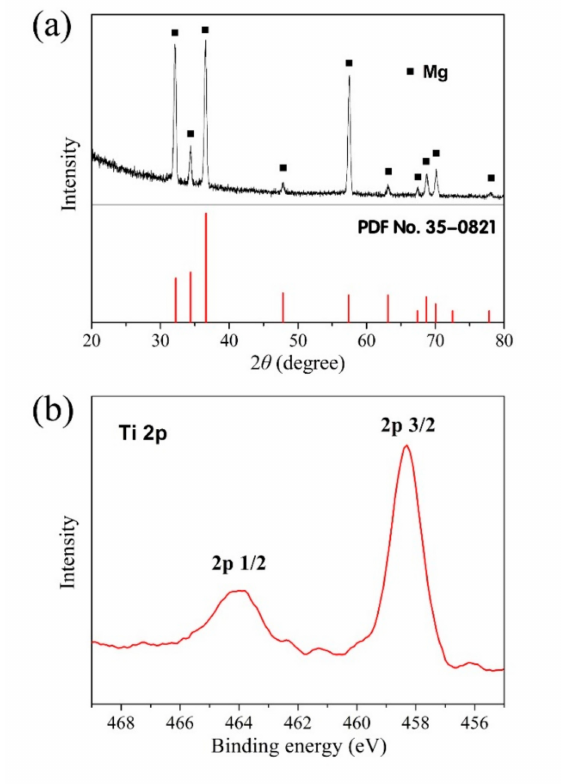
Figure 3. ( a ) XRD pattern of the titanium oxide coating along with the substrate and ( b ) XPS pattern of high-resolving Ti 2p on the titanium oxide